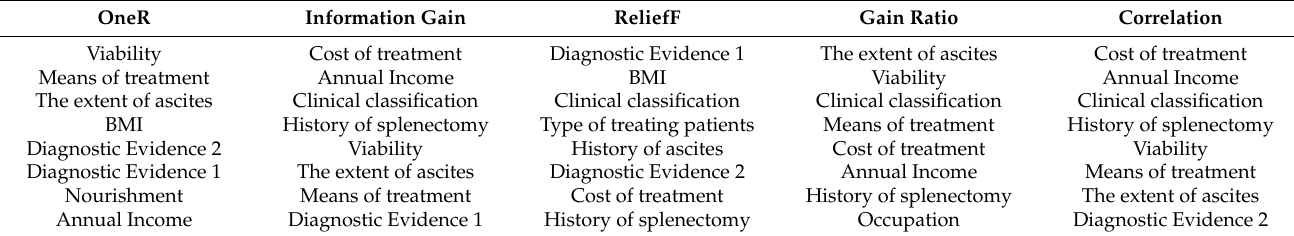
Table 2. Selected features from multiple feature selection techniques.